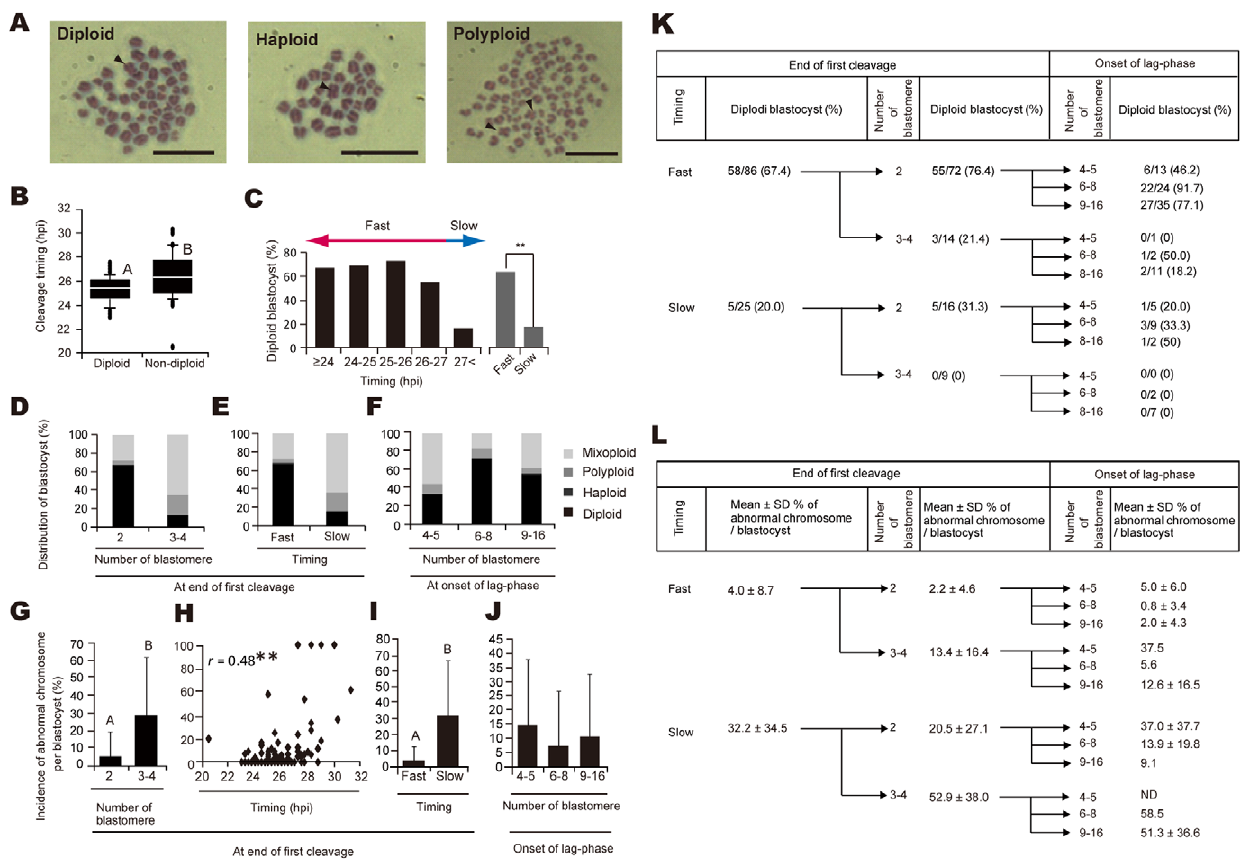
Figure 4. Involvement of cytokinesis during invitro development on chromosome complementation. ( A ) Two sets (2n=60), one set (n=30), and more than two sets of chromosomes (3n, 4n, 5n etc.) were considered diploid, haploid, and polyploid, respectively. The arrowheads indicate the X chromosome. Bar=10 m m. ( B ) The timing of the first cleavage in diploid embryos (defined as blastocysts in which all nuclei were diploid) and non-diploid embryos (defined as blastocysts with more or fewer than two sets of chromosomes in the analyzed nuclei). Different letters indicate significant differences between groups based on one-way ANOVA followed by Fisher’s PLSD ( A,B P , 0.01). ( C ) Relationship between timing of the first cleavage and the incidence of diploid embryos. Blastocysts were divided into two groups, fast and slow, based on the timing of the first cleavage with a cut-off of 27 hpi ( C ). Double Asterisks indicate significant differences between groups based on the x 2 test ( P , 0.01). Ploidy ( D – F ) and incidence of abnormal chromosomes per embryo ( G – J ) in blastocysts derived from embryos with 2 and 3/4 blastomeres at the end of the first cleavage ( D and G ); rapidly cleaving and slowly cleaving embryos at the end of the first cleavage ( E , H , and I ); and embryos with 4/5, 6–8, and 9–16 blastomeres at the onset of the lag-phase ( F and J ) are shown. **Coefficient of determination, r , was statistically significant based on simple regression analysis ( P , 0.01) ( H ). Different letters indicate significant differences between groups based on one-way ANOVA followed by Fisher’s PLSD ( A,B P , 0.01) ( I ). The incidence of diploid blastocysts ( K ) and the incidence of abnormal chromosomes per blastocyst ( L ) were classified according to the timing and blastomere number at the end of the first cleavage and the blastomere number at the onset of the lag-phase.